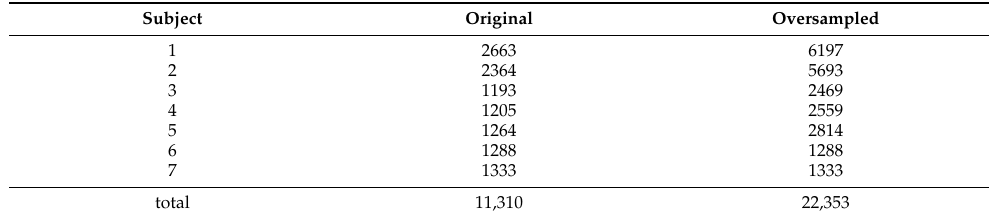
Table 3. Number of data windows for the 7 subjects (oversampling applied to the first 5 subjects